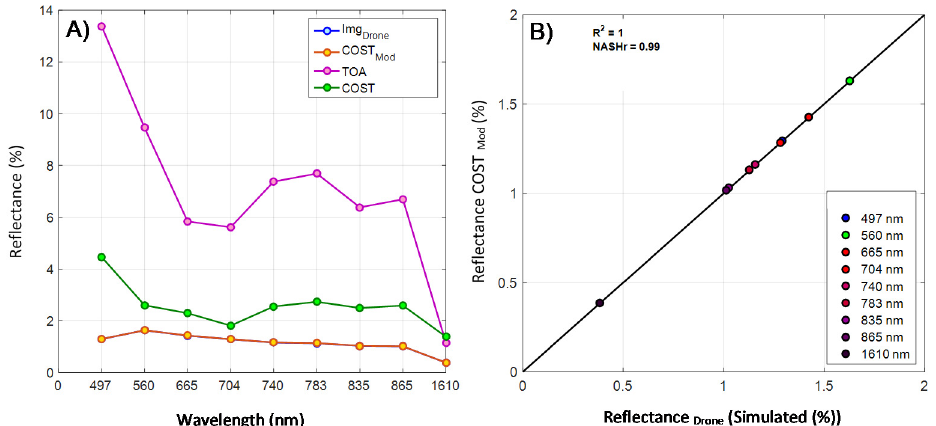
Figure 9. Comparison of Magog Lake reflectance. ( A ) Sentinel-2 based reflectance (11 August 2017) corrected using: radiometric correction (Top of atmosphere (ToA)), COST algorithm, and a modified version of the COST ( COST Mod ) algorithm and reflectance of drone image ( Img Drone ) for the field campaign of the 14th August 2017. ( B ) Line 1:1 plot comparing COST Mod to Img Drone reflectance’s. Reflectance presented here are averages picked up over in situ sampling points.